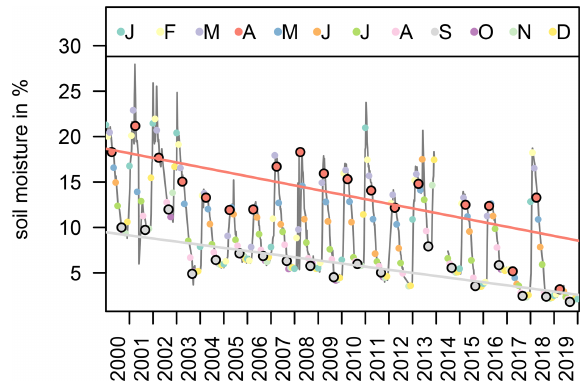
Figure 5. Example of the calculation of monthly linear regressions for April and September at NP 3 and at a depth of